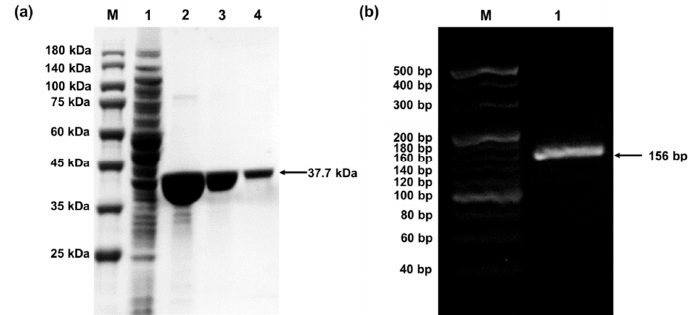
Figure 2. ( a ) SDS ‐ PAGE result of p PaFRS. M: protein marker (PM2510, Transgen, China); 1: Cell lysate of induced BL21(DE3); 2, 3, and 4: different loading amounts of p PaFRS. ( b )